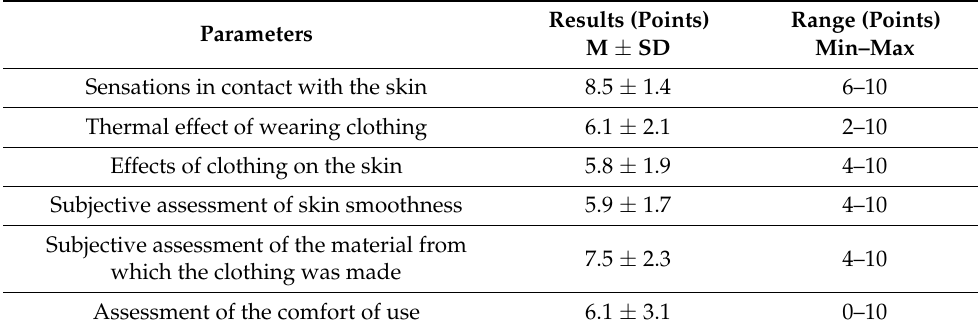
Table 10. Subjective assessment of sensations during the 6 weeks of use of